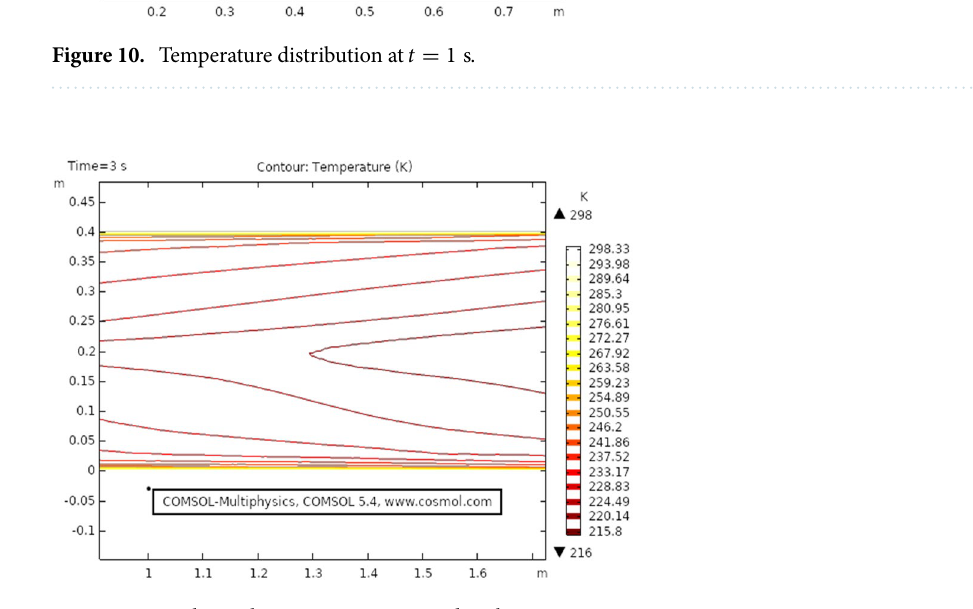
Figure 11. Isothermal contour temperature distribution at t = 3 s